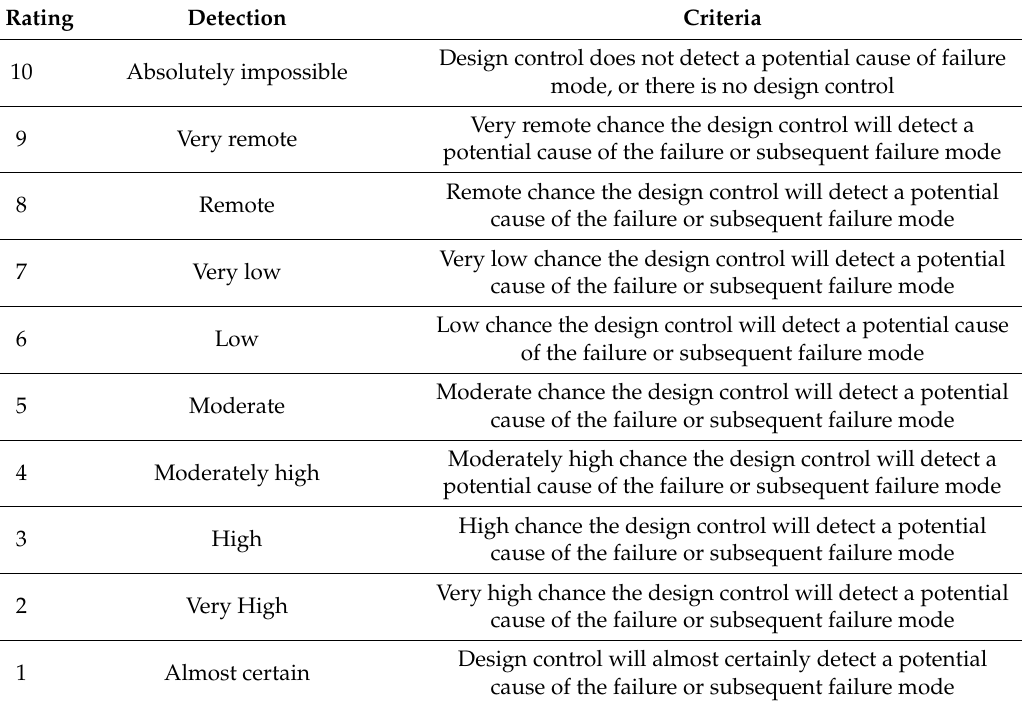
Table 3. Traditional ratings for failure mode’s detection (DET)